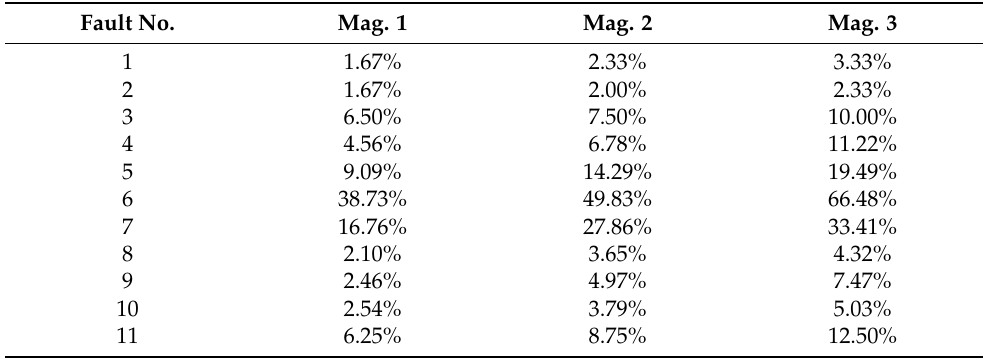
Table 4. Relative magnitudes in abrupt faults. Fault No.